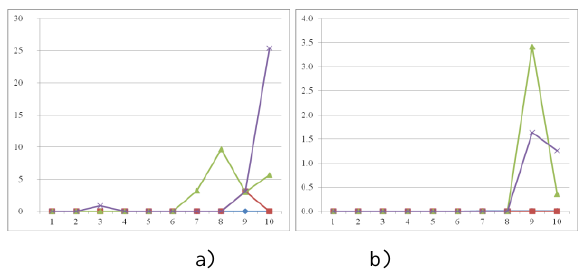
Figure 9 Low urban density area: a) additions and b) deletions Figure 9 represents the additions and deletions for the low urban density category. The line colours represent the low